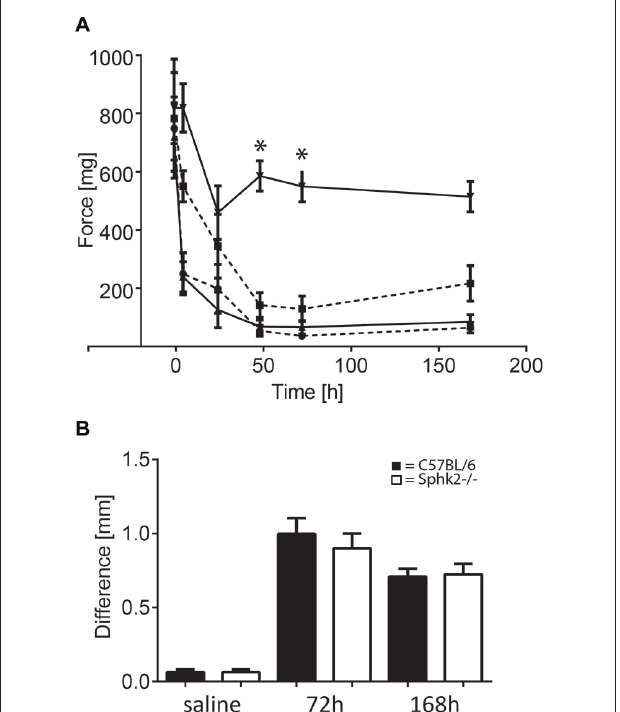
FIGURE 6 | Paw withdrawal thresholds in response to chronic peripheral inflammation (CPI) induced by CFA in C57BL/6 and Sphk2 − / − mice. (A) Time course of paw withdrawal thresholds in response to intraplantar injection of CFA in C57BL/6 ( n = 8, ipsilateral, upwards pointing triangles solid line; contralateral downward pointing triangles solid line) and Sphk2 − / − ( n = 8, ipsilateral, circles dashed line; contralateral squares dashed line) hindpaws (two-way ANOVA, Bonferroni’s post hoc test, * p < 0.05). (B) Difference in mid-hindpaw thickness of the between ipsi- and contralateral side in response to CFA injection. Values represent mean ±